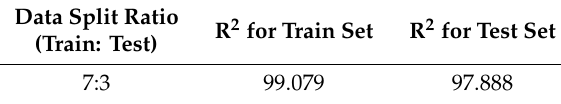
Table 10. Accuracy of XGB regression